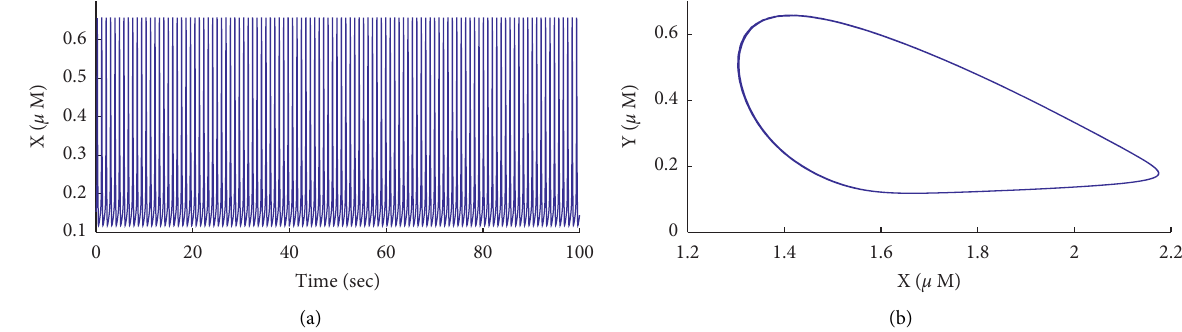
Figure 5: Shape, amplitude, and frequency control of chaotic Ca 2+ oscillation in coupled model (6) of nonexcitable cell at r � 0.95. (a) The respective time course of variable X with controlling rate parameters k c1 � 6, k c2 � 0.2. (b) 2D projection of the trajectory in X, Y phase space with controlling rate parameters k c1 � 6, k c2 � 0.2.